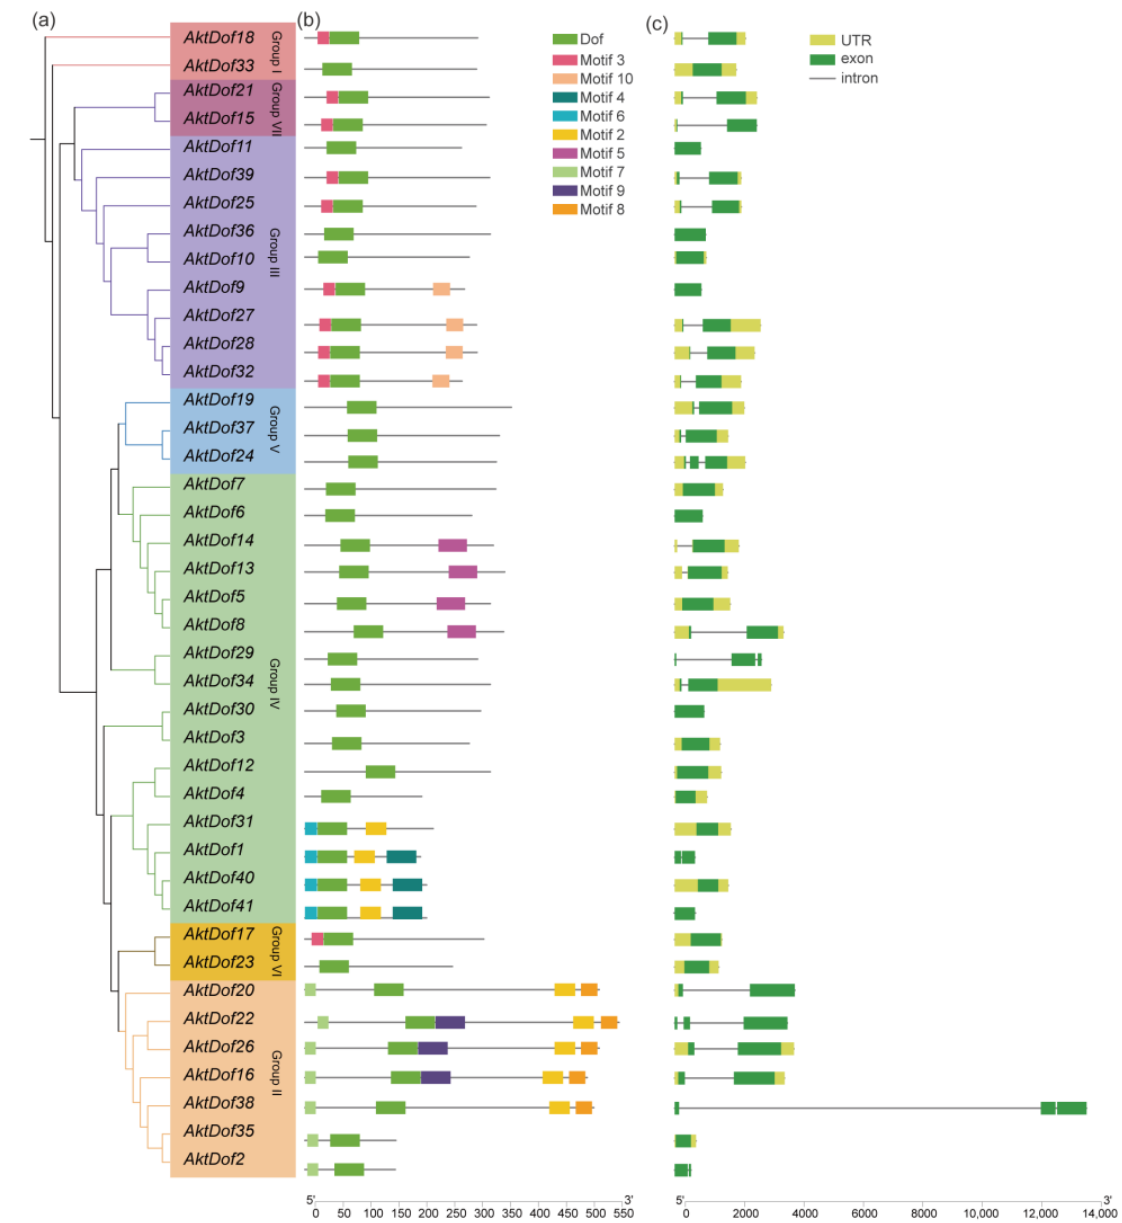
Figure 2. Phylogenetic relationship, conserved motif analysis, and gene structure of AktDofs . ( a ) Phylogenetic tree of 41 AktDof proteins. ( b ) Conserved motifs of the AktDofs protein. ( c ) Exon-intron structure of the AktDofs . The 10 top conserved motifs are shown in different colored boxes. The green boxes represent exons, the black lines represent introns, and the upstream/downstream regions of the AktDofs are shown in yellow.